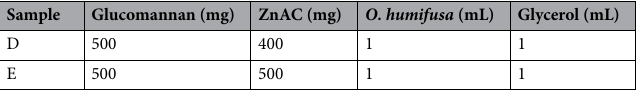
Table 1. The formulations of hand gels in cytotoxicity assay.